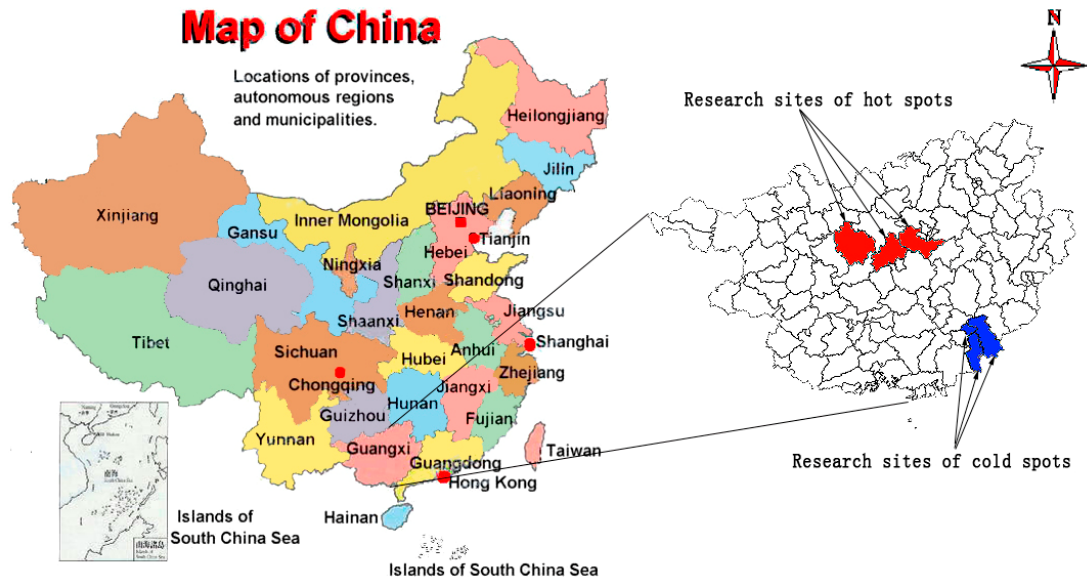
Figure 1. Research sites of hot and cold spots in Guangxi, China.